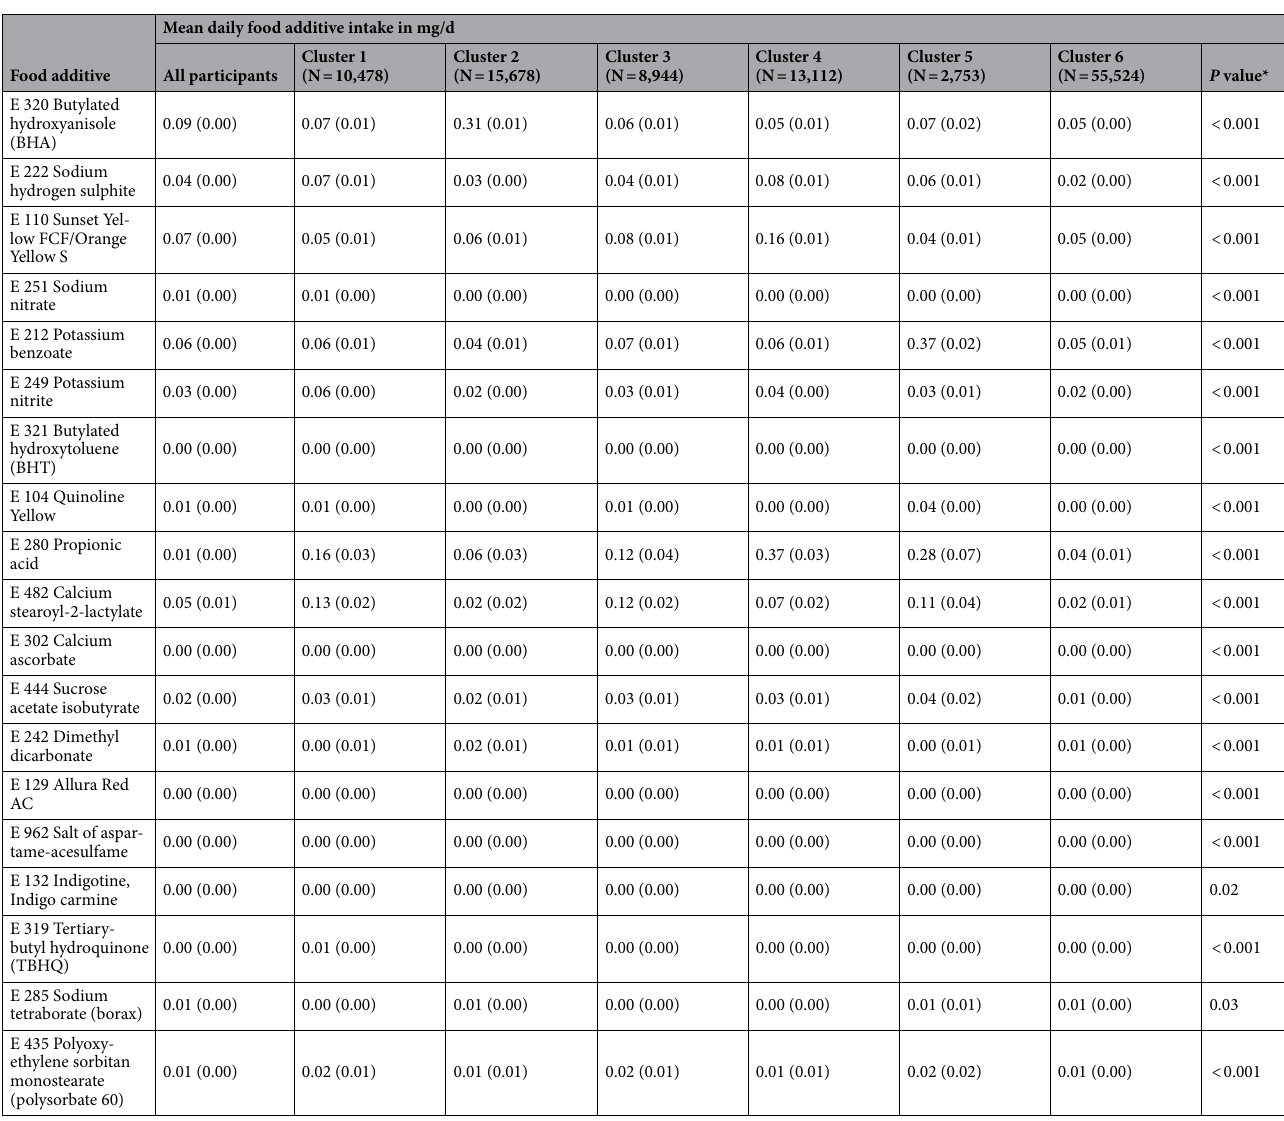
Table 3. Intake of food additives according to clusters of food additive consumers, NutriNet-Santé cohort, France, 2009–2020 (N = 106,489). Weighted according to the French national census report data by using